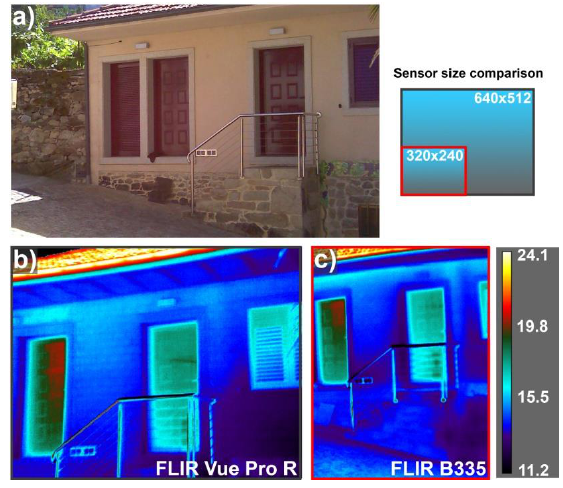
Figure 6. ( a ) RGB (red-green-blue) images of part of the building and thermograms obtained from the same point (~4 m from the façade) with ( b ) the FLIR Vue Pro R and ( c ) FLIR B335 cameras. The same colour palette and ST scale are used. The temperature scale is in °C.